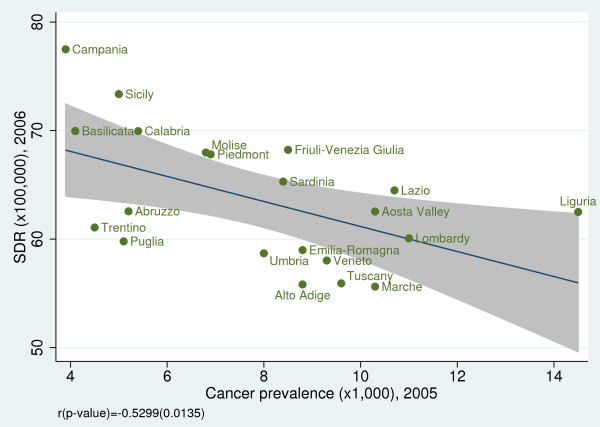
Amenable mortality vs. cancer prevalence; cancer includes all types of malignant tumors. Data source: Indagine Istat su condizioni di salute e ricorso ai servizi sanitari 2004–2005 [15].